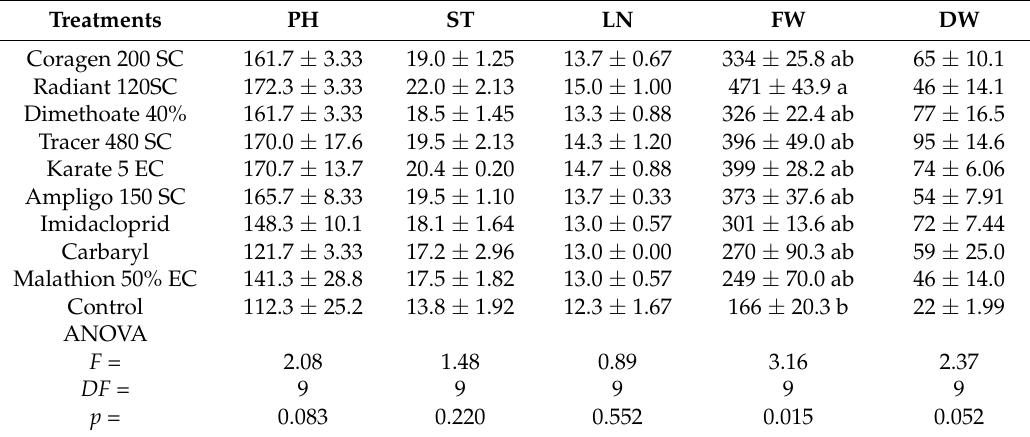
Figure 1. Mean (± SEM) leaf damage of maize by FAW under different treatments in the greenhouse. Table 5. Mean percentage (± SEM) of plant height, stem thickness, leaf number, fresh and dry weight of maize under different synthetic insecticide treatments in the greenhouse.